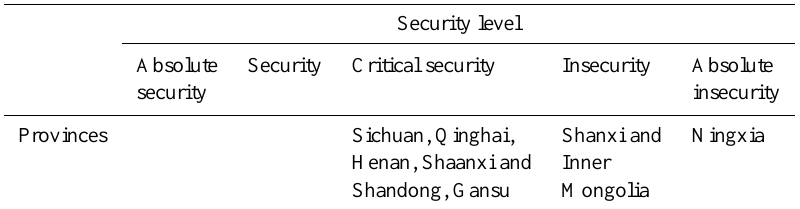
Table 10. Water resources security levels in administrative regions in the Yellow River basin under the Copeland aggregation method (in